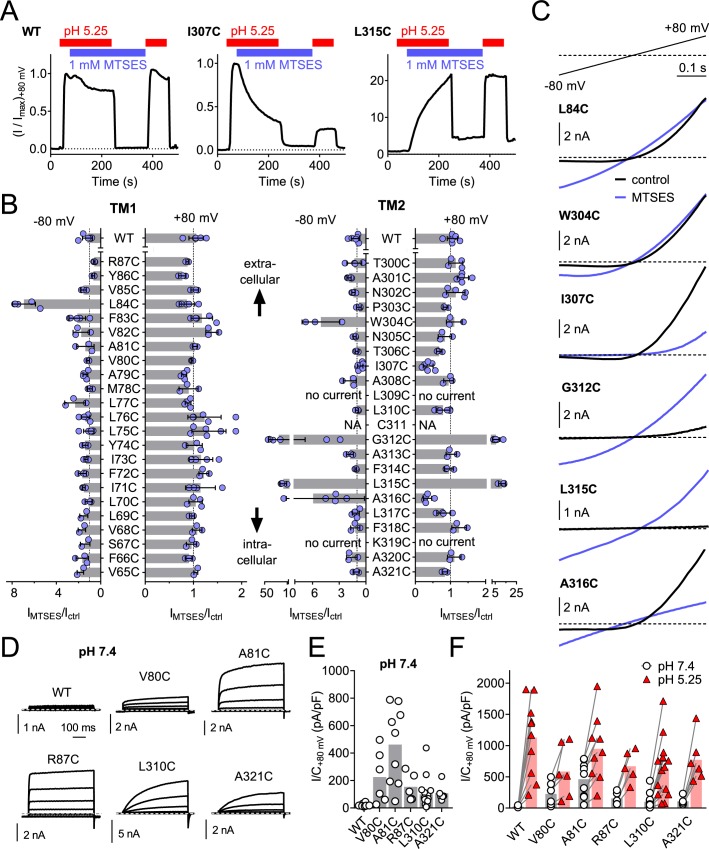
Substituted cysteine accessibility scan of TMEM206 transmembrane domains.(A) Effect of MTSES on currents from WT and mutant TMEM206-transfected TMEM206−/− cells. MTSES had no effect on WT TMEM206, but acutely and irreversibly decreased or increased ICl,H of I307C and L315C mutants, respectively. Note that acidic pHo does not interfere with MTSES reactivity. The protocol was designed to be able to detect potential effects of MTSES at pH 7.4. (B) Ratio of current before (Ictrl) and after (IMTSES) exposure to MTSES, at +80 and −80 mV. Mutants are grouped by location within the two TMDs of TMEM206. For current amplitudes of non-modified cysteine mutants, see Figure 6—figure supplement 1. (C) Current traces of selected mutants elicited by voltage ramps (top) before and after MTSES-application. (D–F) Cysteine mutants showing currents at pHo 7.4. (D) Voltage-clamp traces of WT TMEM206 and indicated mutants at pH 7.4. Clamp protocol as in Figure 3A. (E) Mean current densities at pH 7.4. (F) All mutants still responded to low pHo.10.7554/eLife.49187.018Figure 6—source data 1.Raw data for Figure 6.